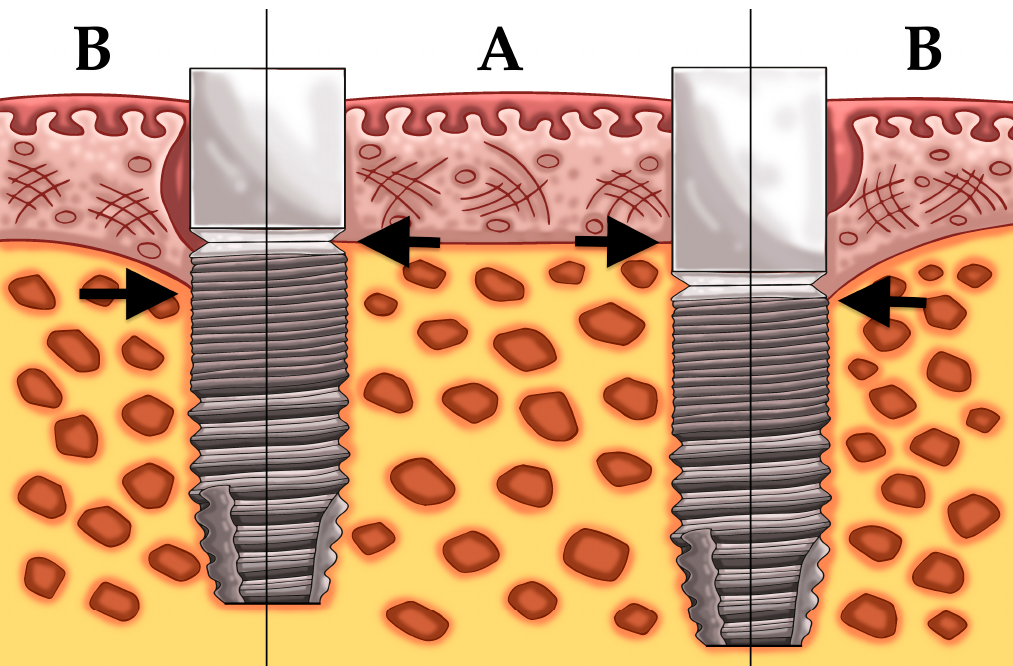
Figure 5. Schematic illustration of study 1, left equicrestally placed implant (group 1) and right subcrestally placed implant (group 2); showing the bone level at baseline (A) and bone level after bone remodeling (B).